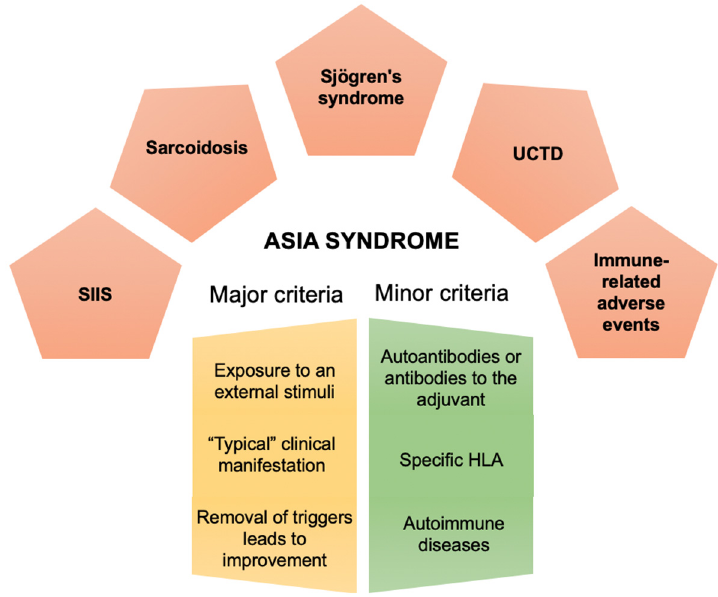
Figure 1. Diagnostic criteria for the ASIA syndrome and the five classical examples of this condition. ( SIIS : silicone implant incompatibility syndrome; UCDT : undi ff erentiated connective tissue (SIIS: silicone implant incompatibility syndrome; UCDT: undifferentiated connective tissue disease).